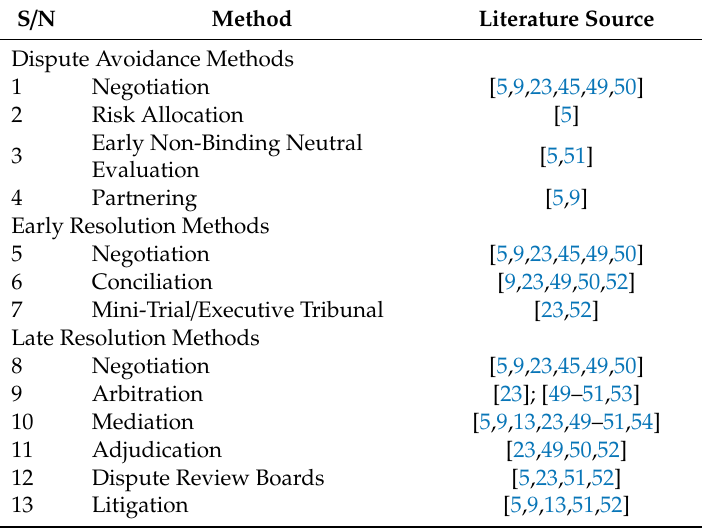
Table 3. Summary of dispute avoidance and resolution